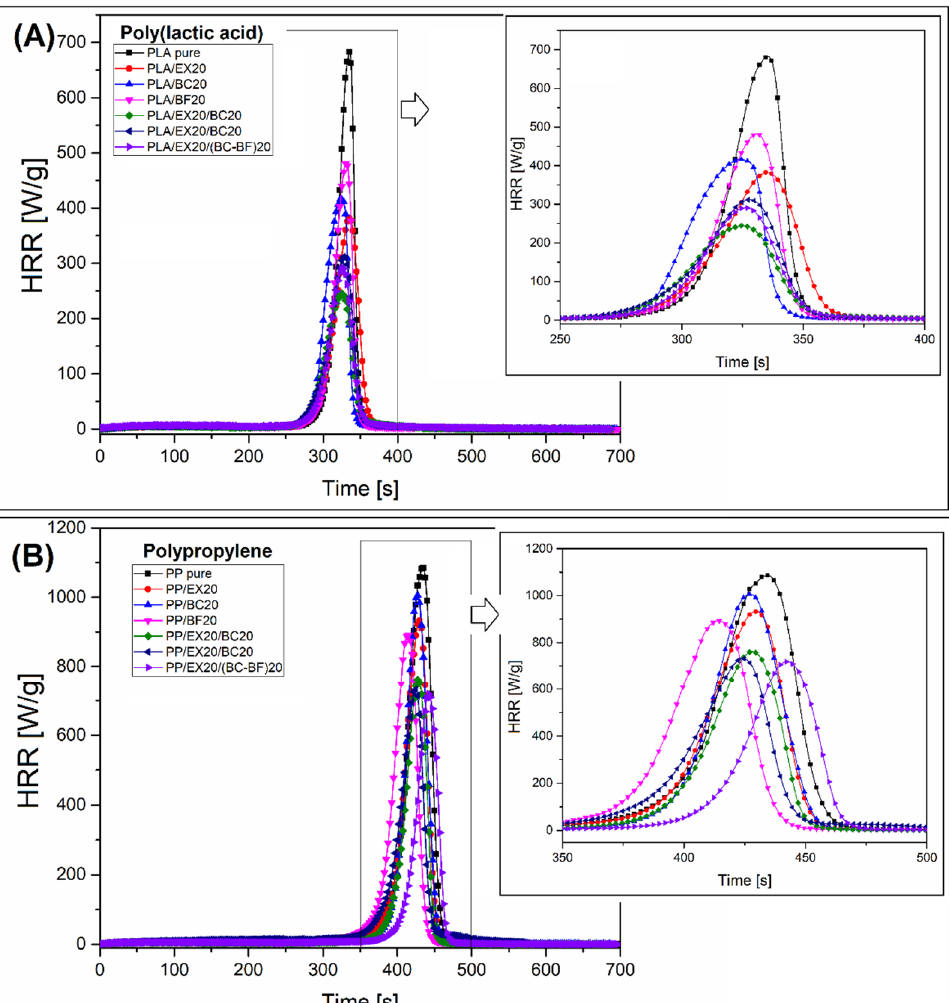
Figure 10. The relationship of the heat release rate (HRR) as a function of the measurement time of materials based on ( A ) PLA and ( B ) PP.